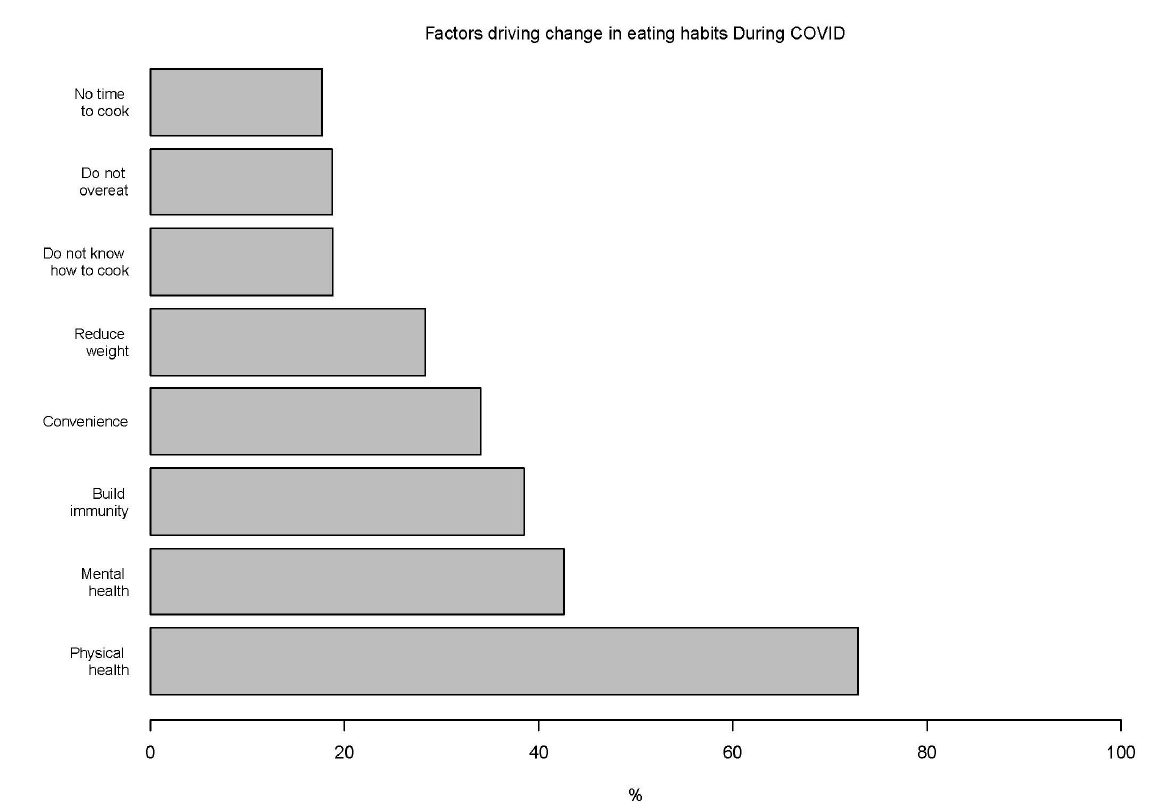
Figure 4. Top factors reported by percentage of participants contributing to a change in dietary